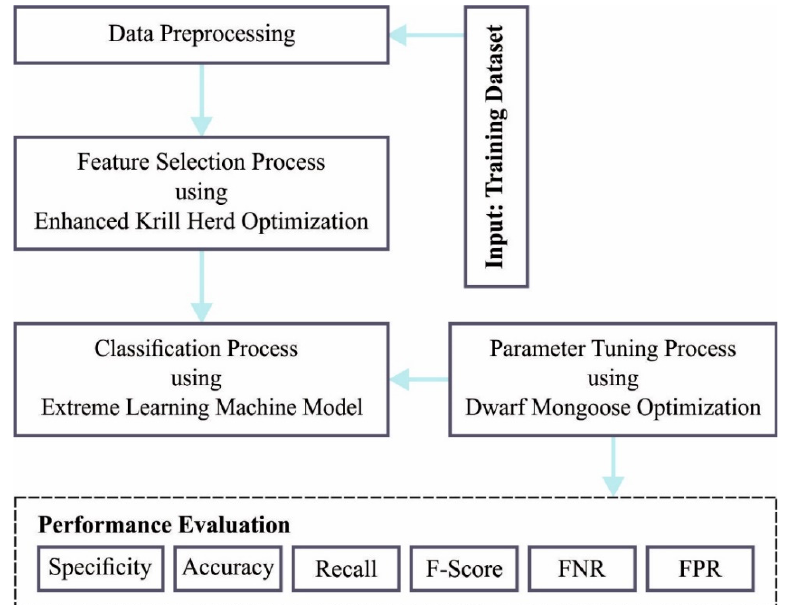
Figure 1. Block diagram of DWOML-RWD approach.